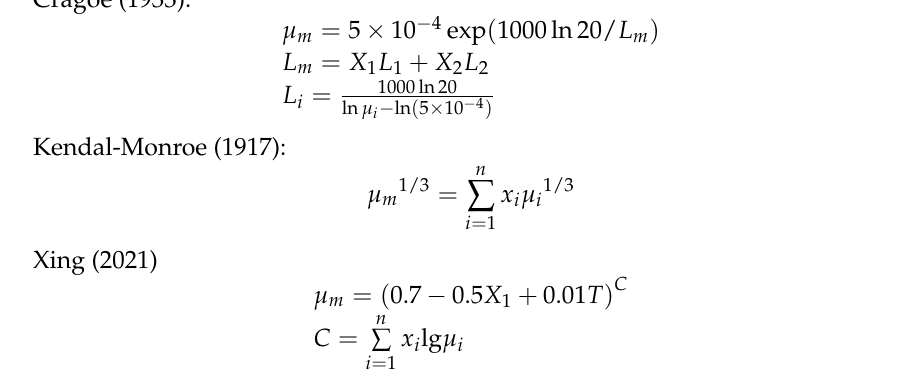
Figure 7. Regression plot of experimental versus tested viscosity.